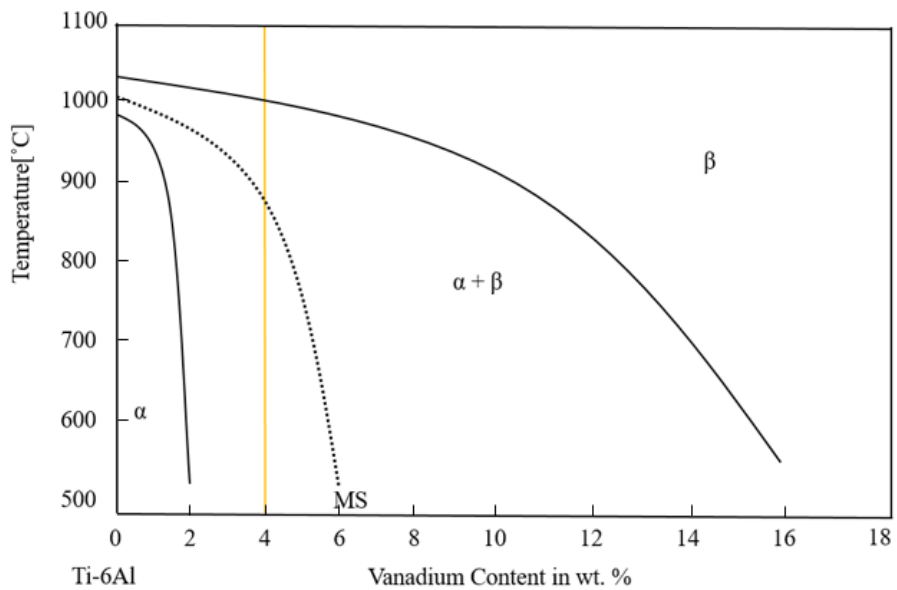
Figure 5. Schematic binary phase diagram of Titanium alloy. Reprinted with permission from [21].